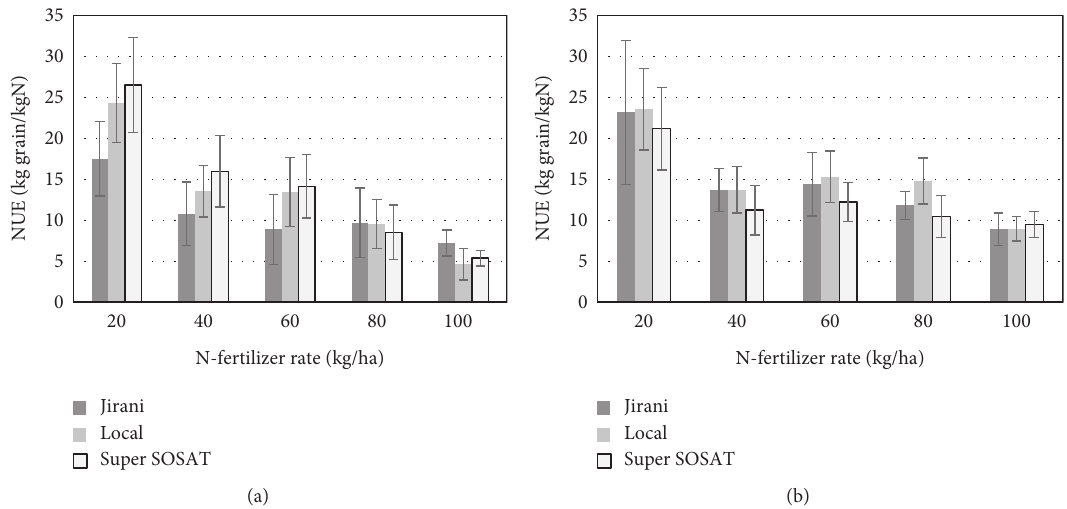
Figure 4: Nitrogen-use efficiency of pearl millet cultivars across N-fertilizer rates in Minjibir and Gambawa (mean of 2014 and 2015 cropping season). LSD ( P ≤ 0 . 05 ) for nitrogen was 6.6 ∗∗ and variety was 3.3 ∗ at Minjibir; LSD ( P ≤ 0 . 05 ) for nitrogen was 5.3 ∗∗ and variety was 3.1 ns at Gambawa. (a) Minjibir and (b) Gambawa.